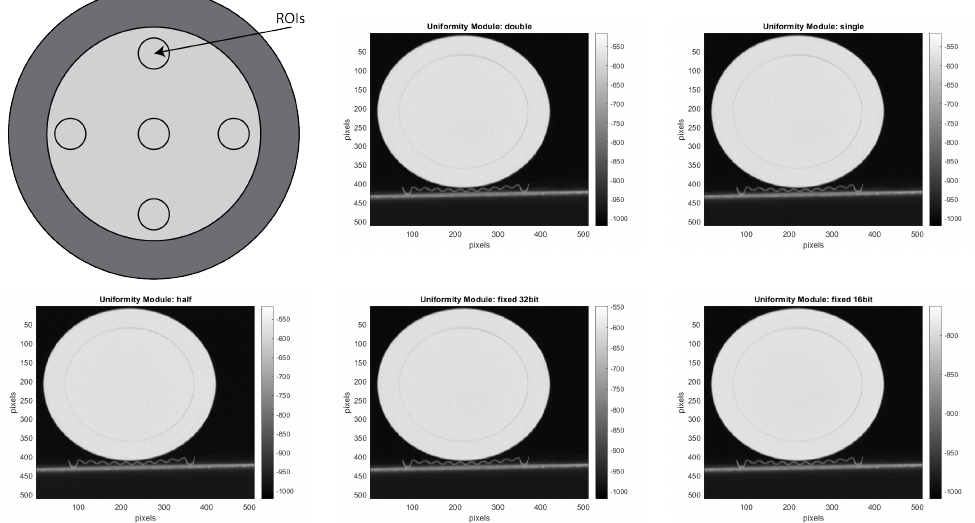
Figure 17. Reconstructed image of the CTP486 module, for noise and uniformity analysis.